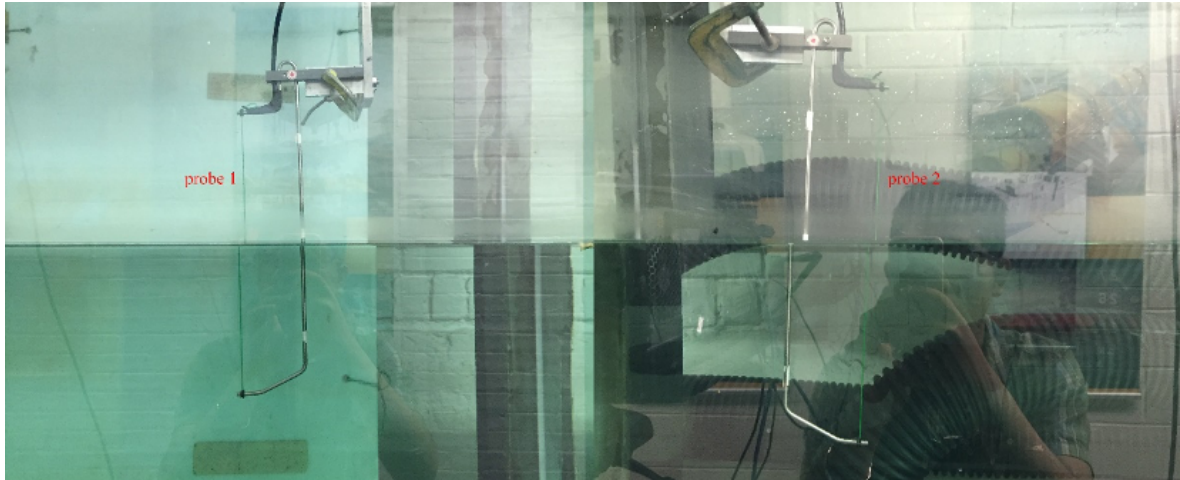
Figure A1. Picture of the experimental tank with a close up on the installed probes. The wire of each capacitance probe is directly facing each